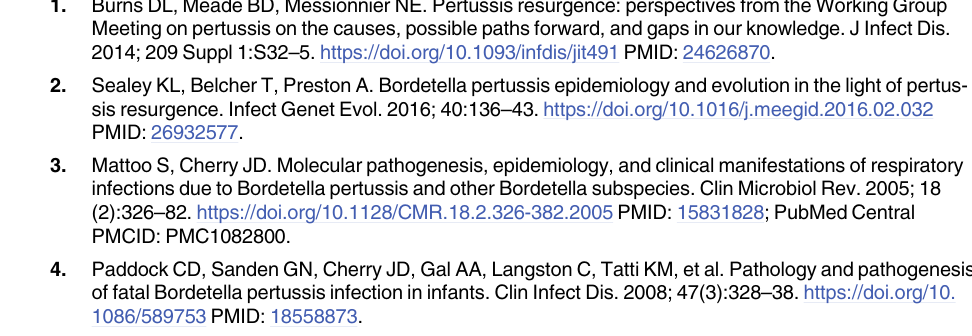
S3 Table. List of PCR primers used for verification of Bordetella chromosome mutations. The analyzed strain, primer sequence (5 0 -3 0 ) and its position in chromosome are provided. S4 Table. List of mammalian and yeast cells used in this study. Name, description and refer- ence are